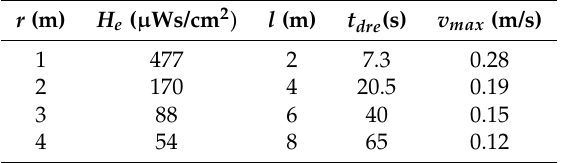
Table 4. Examples of maximum speed for a given surface